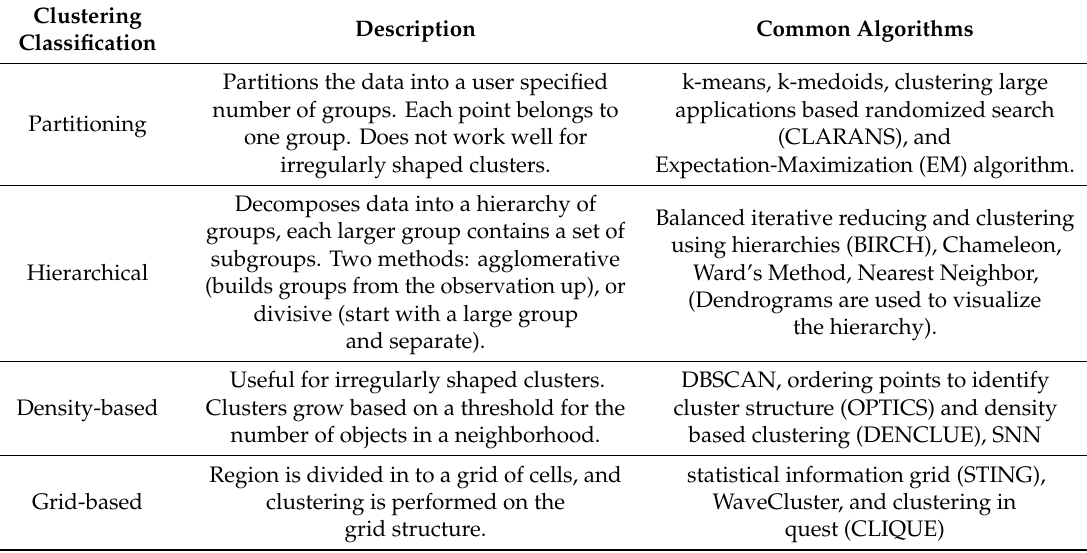
Table 1. Summary of clustering classifications and the common algorithms used to achieve partitioning, hierarchical, density-based, or grid-based approaches